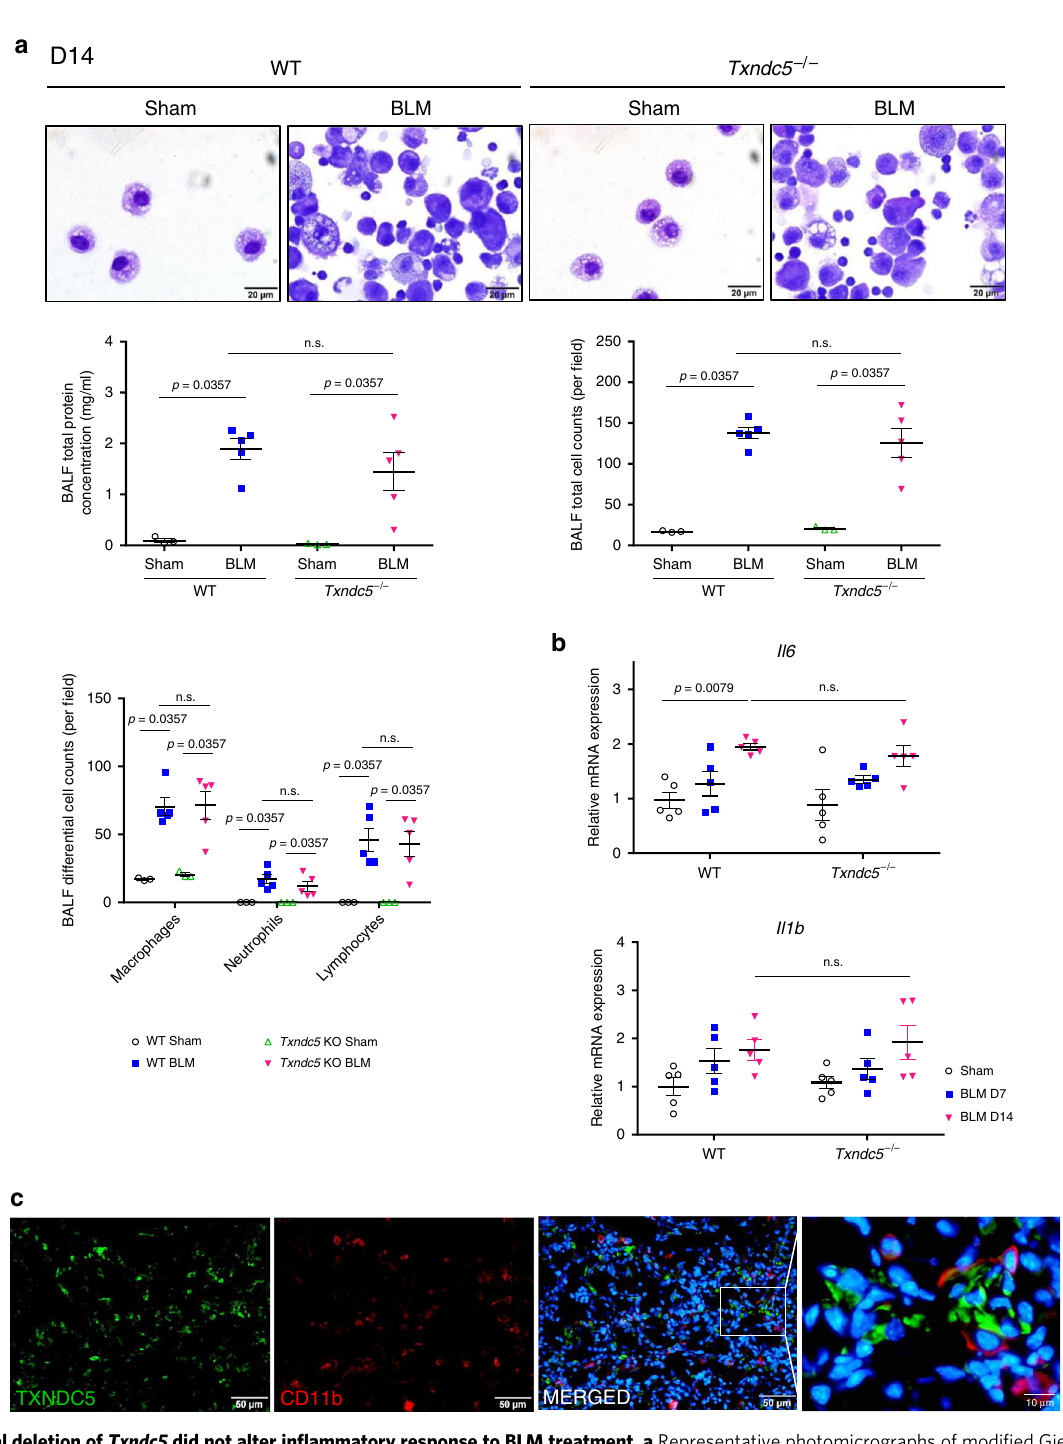
Fig. 4 Global deletion of Txndc5 did not alter in fl ammatory response to BLM treatment. a Representative photomicrographs of modi fi ed Giemsa staining of the bronchoalveolar lavage fl uid (BALF) from WT and Txndc5 − / − mice 14 days after intra-tracheal BLM or PBS (Sham) instillation (top panel). Quanti fi cation of total protein content and number of in fl ammatory cell (macrophage, neutrophil and lymphocytes) in the BALF from each group of the experimental animals (bottom panel) (WT sham n = 3, WT BLM n = 5, Txndc5 − / − sham n = 3, Txndc5 − / − BLM n = 5 biologically independent animals). b Transcript expression levels of pro-in fl ammatory cytokines, Il6 and Il1b , quanti fi ed in the lung tissues from WT and Txndc5 − / − mice 7 days and 14 days after BLM or PBS (Sham) treatment (n = 5 biologically independent animals per group). c Immuno fl uorescence staining of TXNDC5 (green) and CD11b (red) of lung sections from WT mice 14 days following BLM treatment. TXNDC5 was not present in CD11b-positive, in fl ammatory cells (Data are presented as mean ± SEM, P value determined using two-tailed Mann – Whitney U test. Source data are provided as a Source Data fi le. n.s. non-signi fi cant, BLM